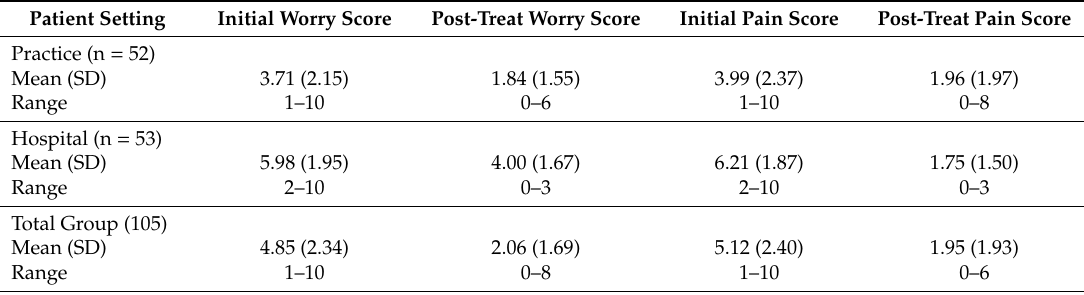
Table 1. Descriptive statistics displaying self-reported pain and worry scores for children seen in primary and secondary care settings.